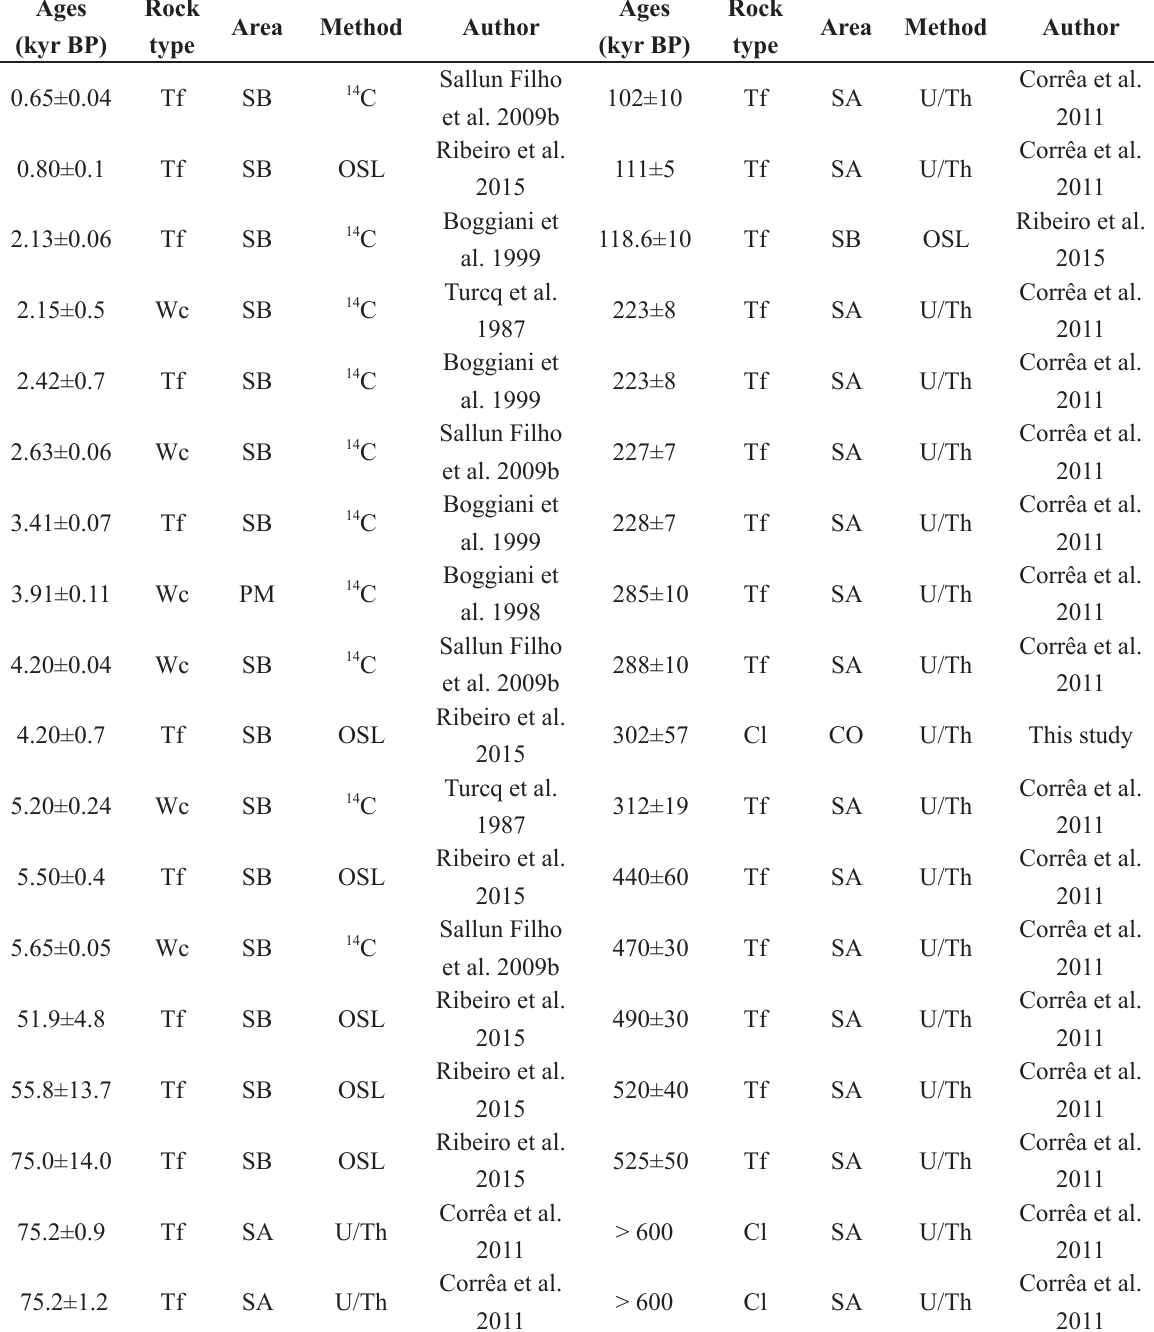
Compiled ages of Quaternary continental carbonates of Serra da Bodoquena, Corumbá plateau, Serra das Araras and Pantanal do Miranda. Symbols: Rock Type: Tf = Tufa; Wc = Wackestone; Cl = Conglomerate; Area: SB = Serra da Bodoquena; Pantanal do Miranda = PM; SA = Serra das Araras; CO = Corumbá/Ladário